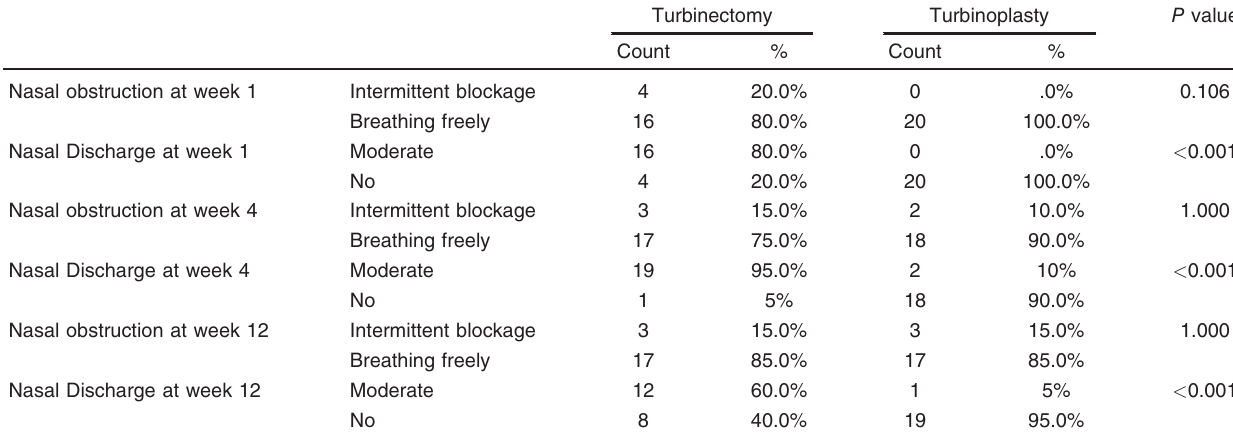
Table 1 Postoperative subjective